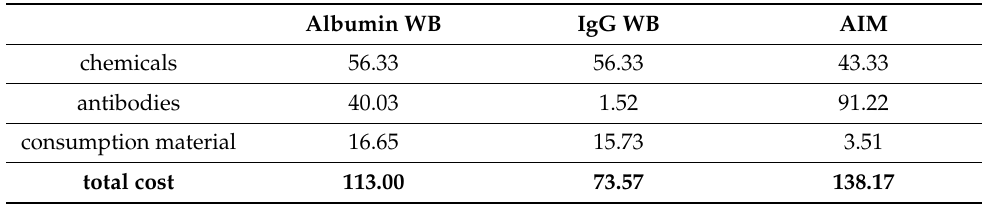
Table 1. The IgG WB is the cheapest method to determine BBB integrity. Prices were determined for n = 8 in Euro on 27 January